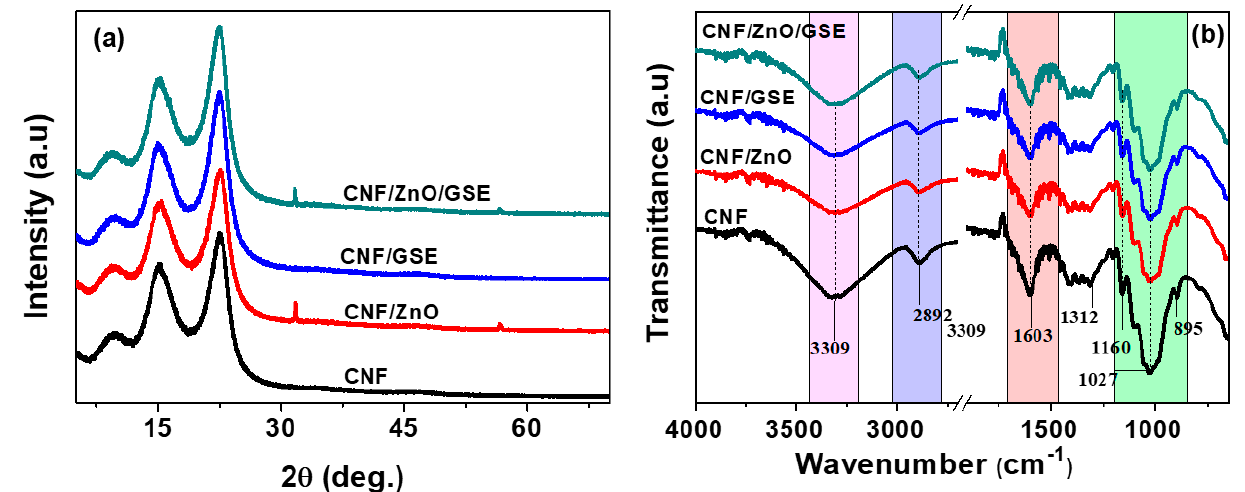
Figure 3. ( a ) XRD patterns and ( b ) FTIR spectra of the neat CNF and CNF/ZnO/GSE nanocomposite films.